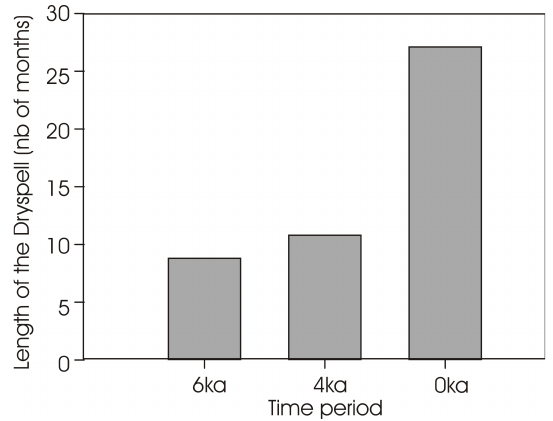
Fig. 7. Mean length of dry spells as simulated at Yoa for 6ka, 4ka and 0ka. Because of the length of the simulations used to com- pute a continuous dry climate would be represented by a length of 492